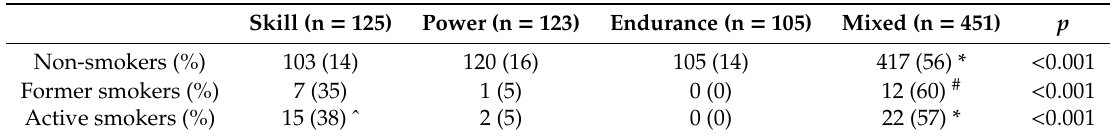
Table 2. Smoking status in di ff erent